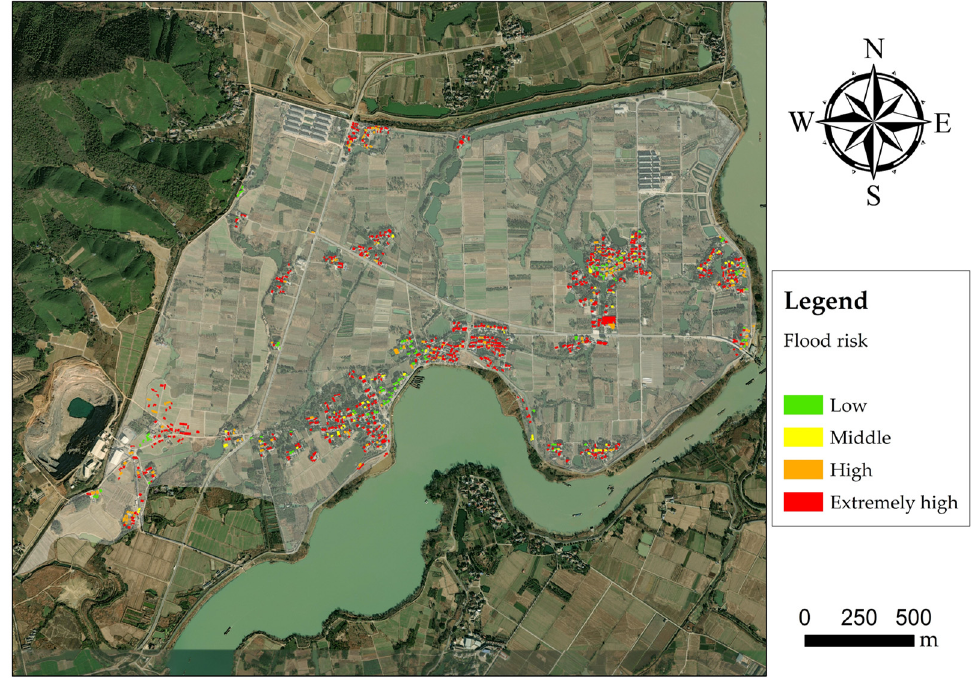
Figure 14. Flood risk assessment of buildings in flood scenario of 100-year return period.